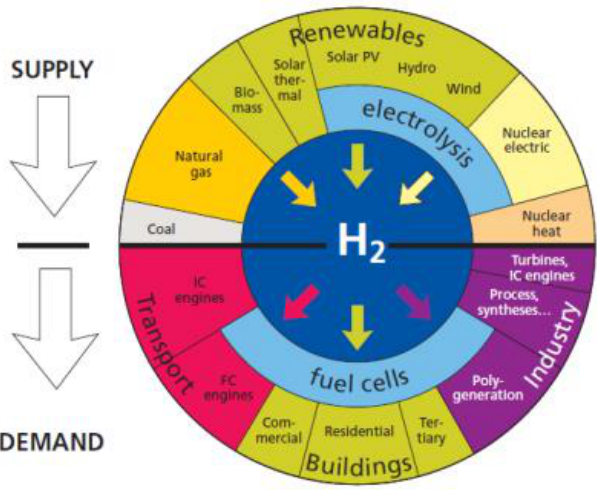
Figure 1. The role of hydrogen [1].